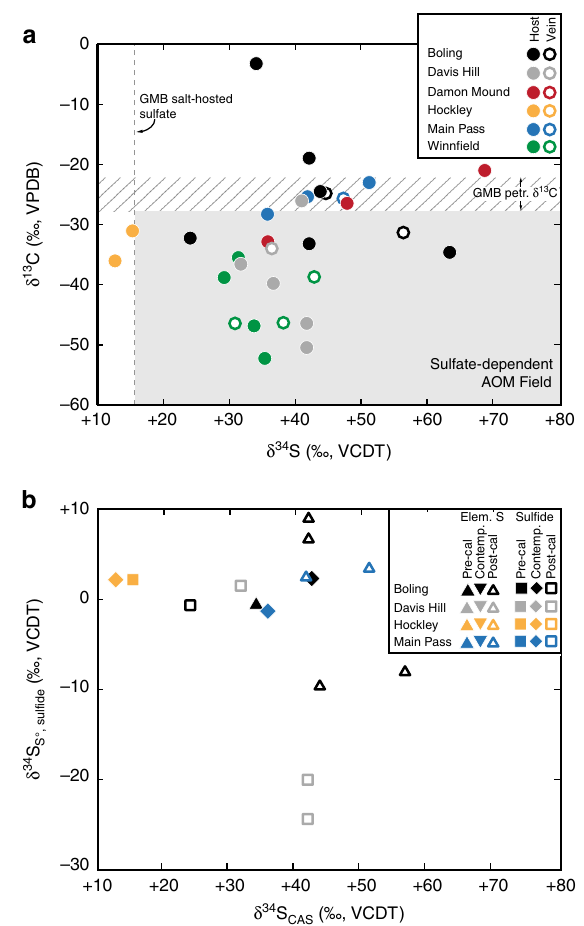
Fig. 5 Carbon and sulfur isotope data of Gulf of Mexico Basin (GMB) cap rock phases. a Carbonate carbon ( δ 13 C carb ) and sulfur isotope ( δ 34 S CAS ) compositions of cap rock carbonate. Early (host) and late (vein) phases are identi fi ed. Also shown are the δ 13 C ranges for northern GMB petroleum (hatched envelope) and the δ 34 S value for minor anhydrite/gypsum in the Louann Salt (vertical dashed line). Carbonate carbon isotope